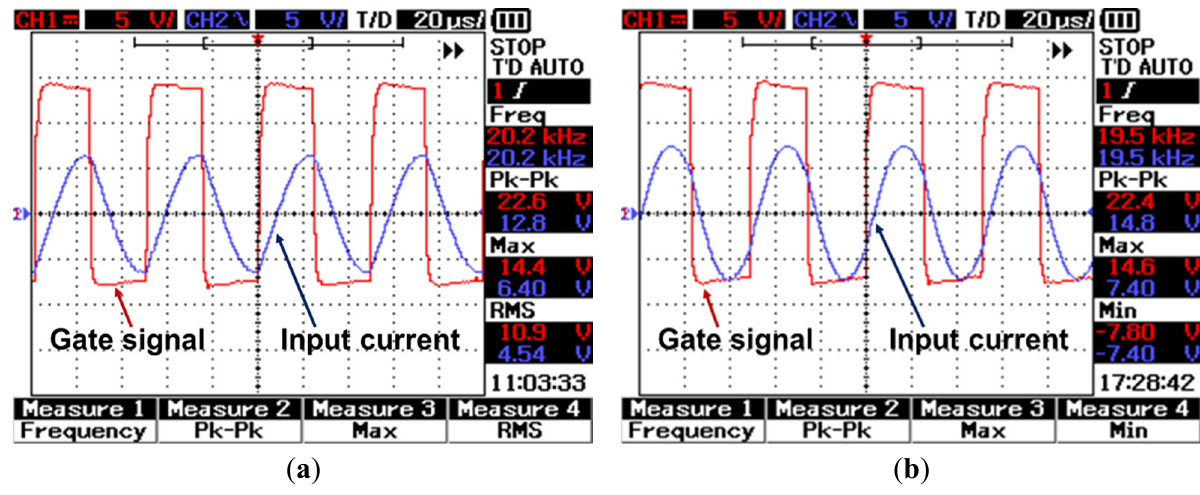
Figure 10. Switching signals and the inverter circulating current under two extreme conditions (misalignment = 200 mm, air gap = 100 mm) ( a ) Fixed frequency control (20.2 kHz); Sinusoidal current waveform: Max = 32 A, RMS = 22.7 A; ( b ) Uniform gain operation (19.5 kHz). Sinusoidal current waveform: Max = 37 A, RMS = 26.2 A. The voltage-current ratio of the current sensor is 0.2